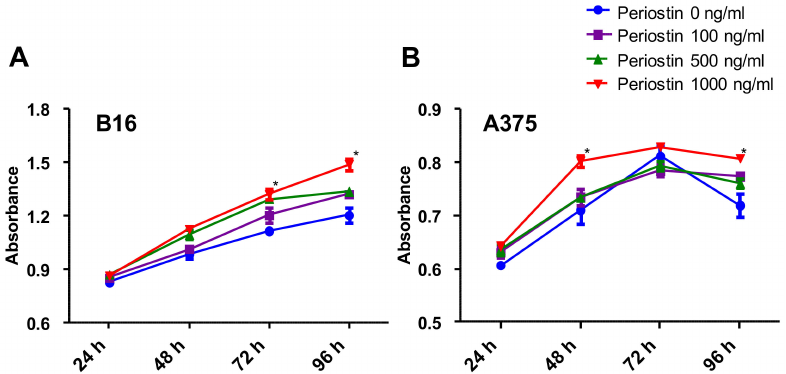
Figure 5. Proliferation assay of ( A ) B16F10 cells and ( B ) A375 cells. Cell proliferation was assessed by WST-1 assay every 24 h for 4 days. Cultures stimulated with periostin showed a significant increase in B16F10 cell number on days 3 and 4, and in A375 cell number on days 2 and 4. Three independent experiments were performed, and representative results are shown. t -test, * p <